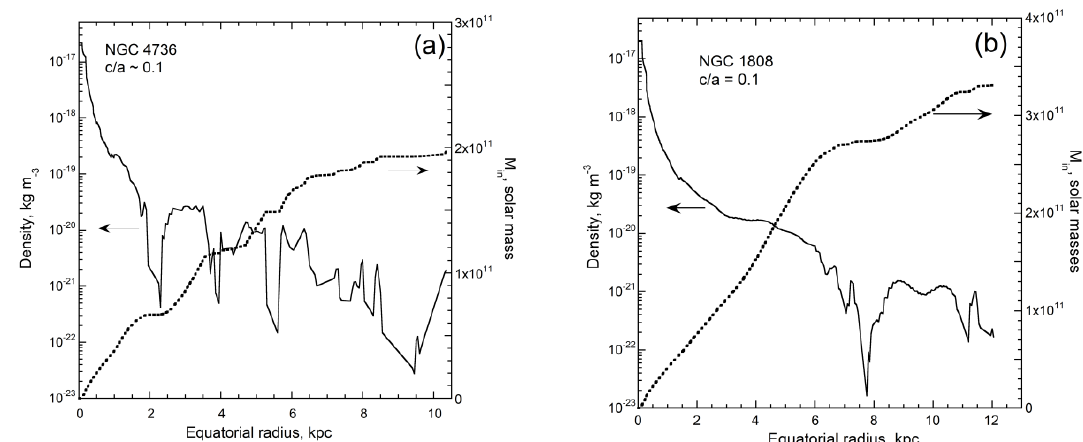
Figure 16. Inverse analysis within the visible disk of counter-rotating spirals. Arrows point to the relevant y-scale: ( a ) NCG 4736, using RC data from deBlok et al. [53], shown in Figure 14; ( b ) NGC 1808, using RC data of Sofue et al. [81], shown in Figure 15.